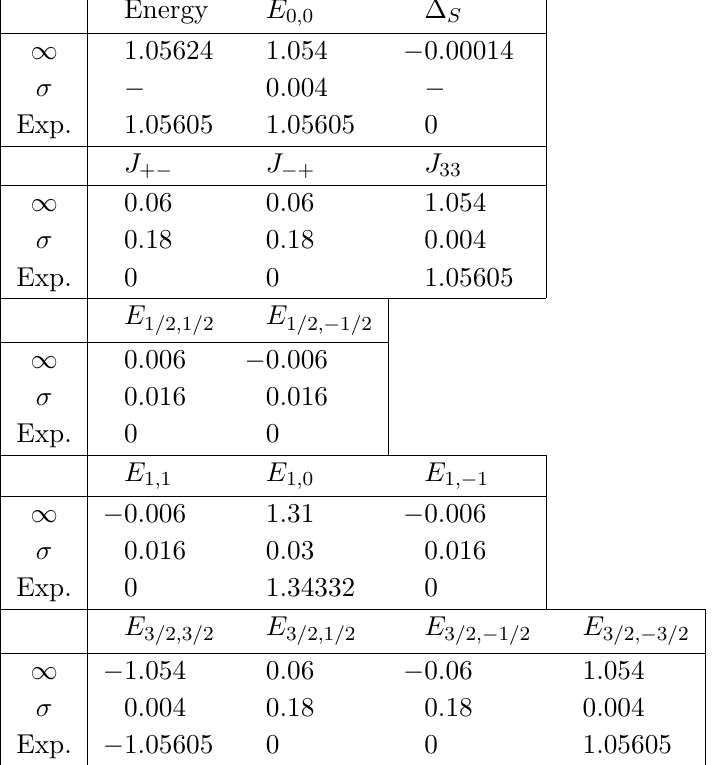
Table 20 . Extrapolations (based on levels 4 to 12) of the B-brane solution in the k = 3 model with boundary J = 1 2